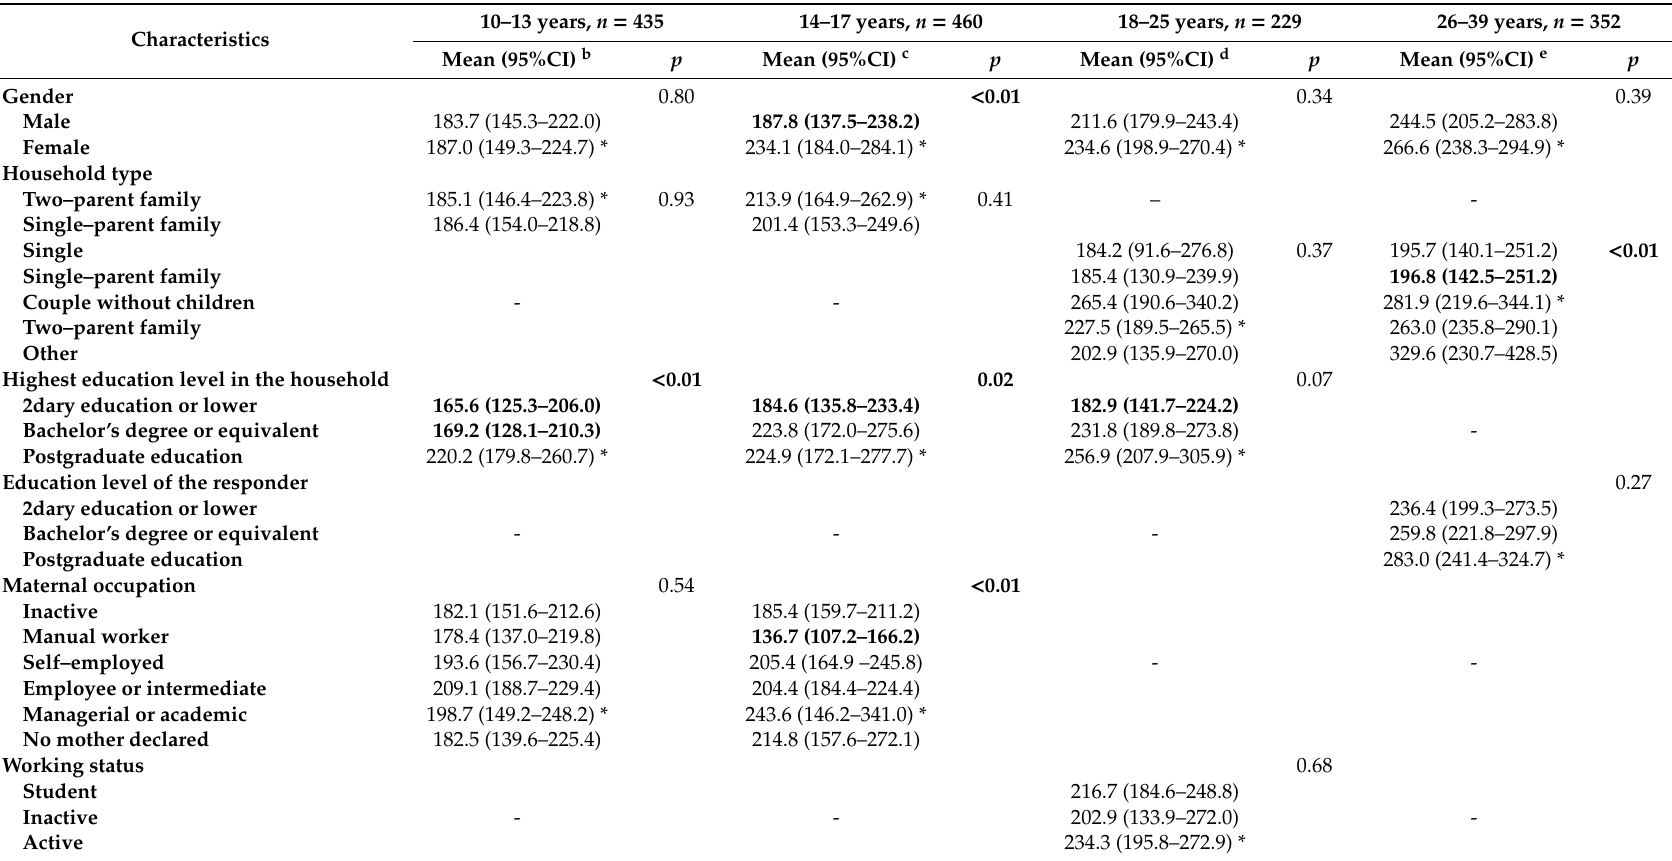
Table 2. Adjusted a mean consumption (g / day) of fruits and vegetables according to socio-economic, cultural characteristics, and age group. Belgian food consumption survey